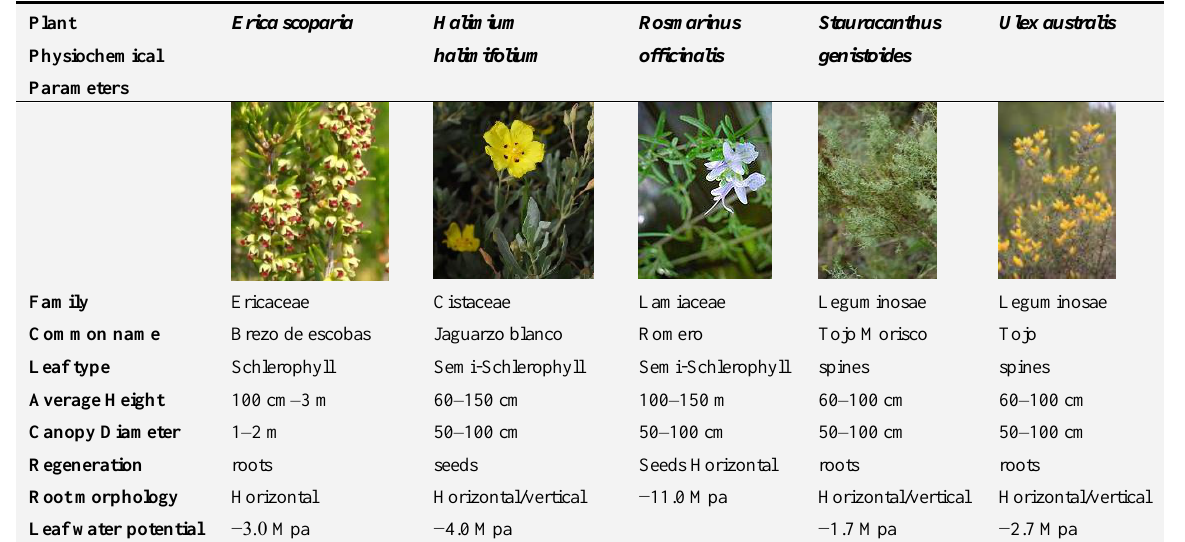
Table 1. Characteristics of the shrub dominant species in the stabilized sand dunes ecosystem of Doñana National